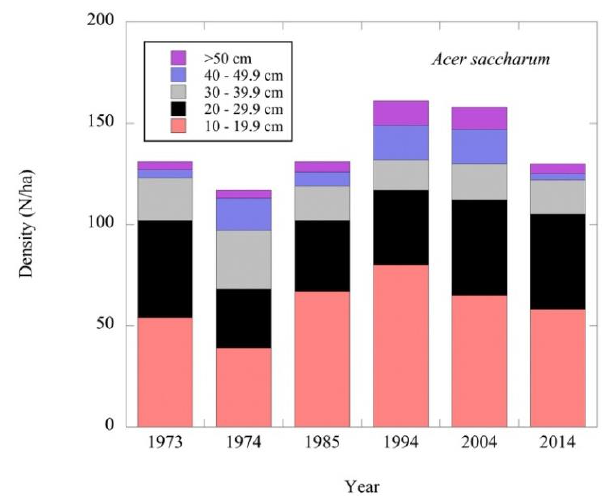
Figure 2. Shannon diversity index values for all canopy (DBH ≥ 30.0 cm) and subcanopy (DBH ≥ 10.0 – 29.9 cm) tree species recorded at Dinsmore Woods across the six sampling periods.